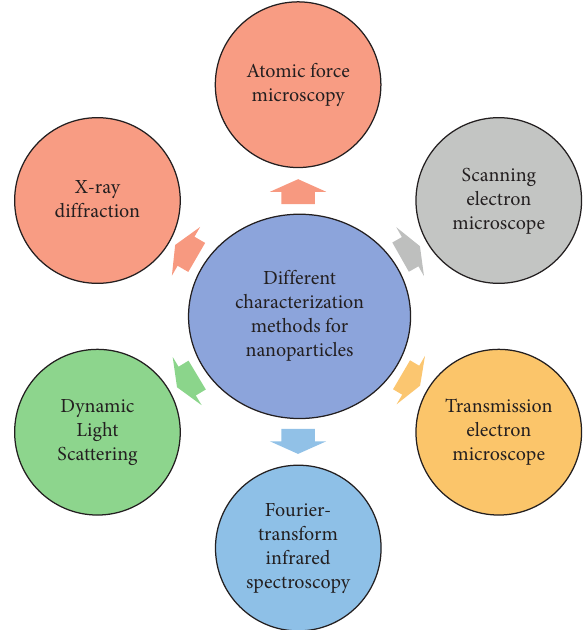
Figure 3: Different characterization methods for